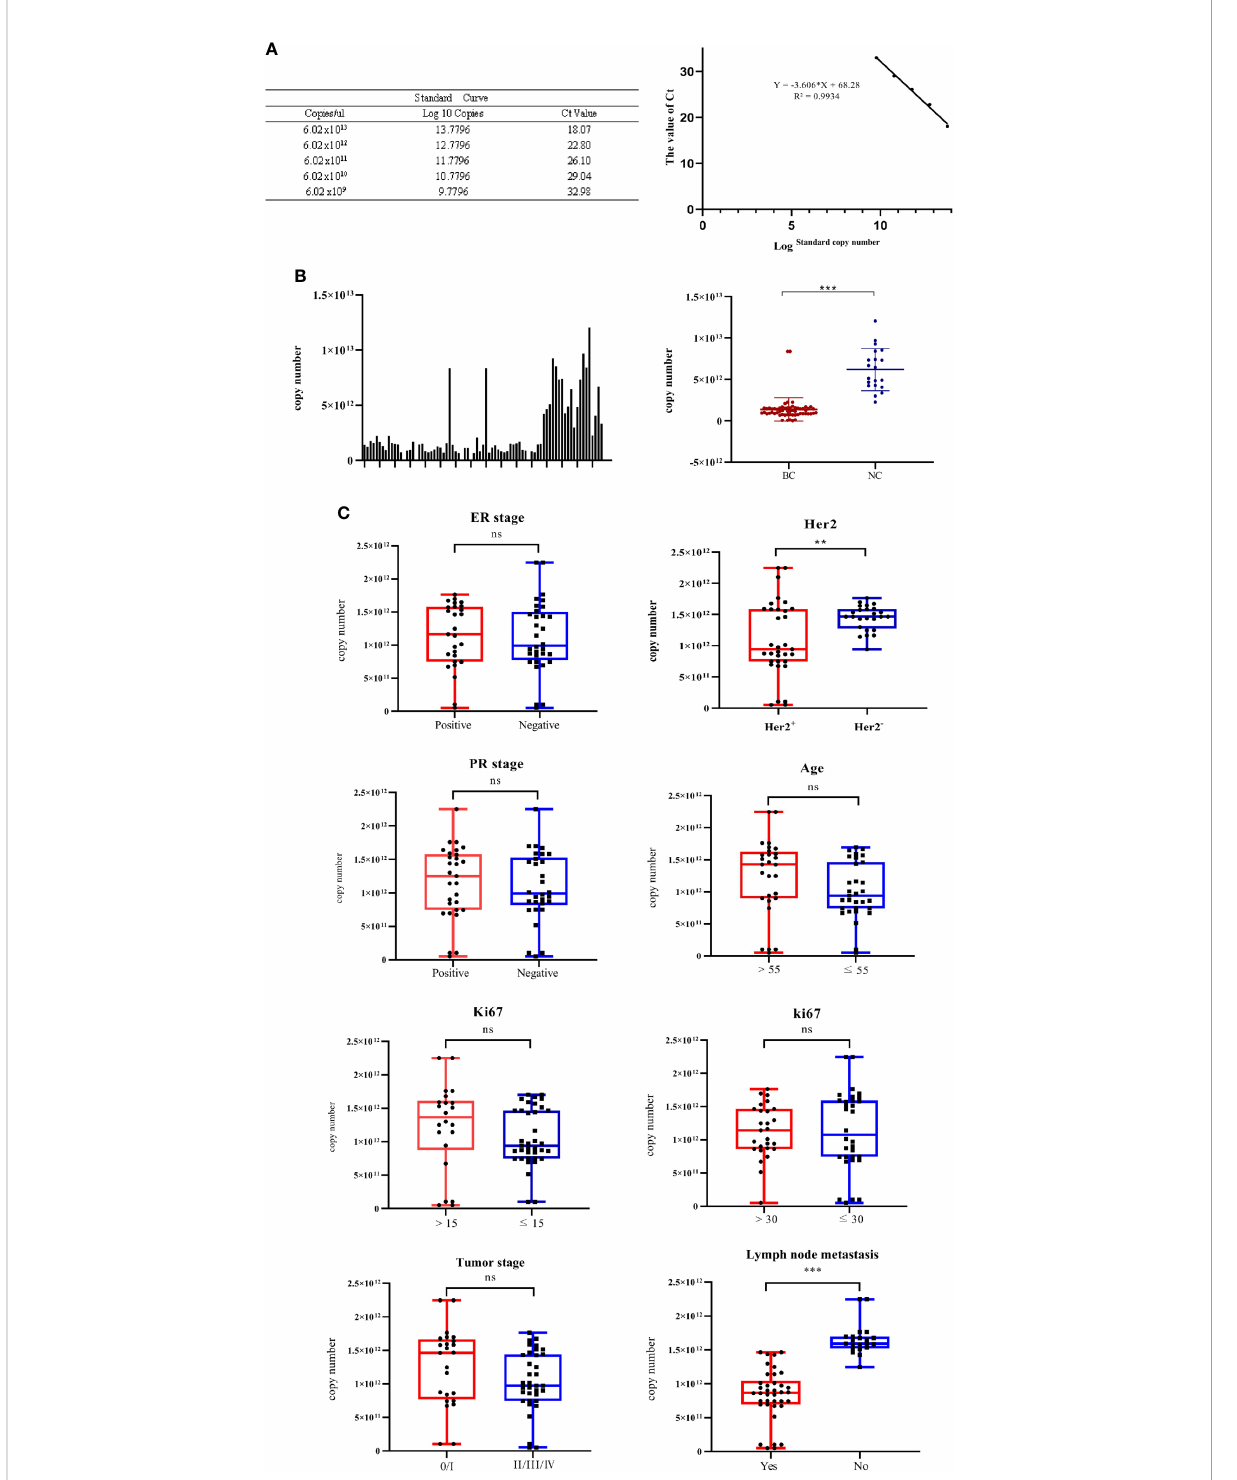
FIGURE 5 The correlations of the levels of exosomal miR-940 with a spectrum of pathophysiological parameters in cancer patients were tested. (A) Standard linear regression curve of miR-940. (B) The copy number of miR-940 transcripts per nanogram of exosomal RNA in each column sample, and the copy number of miR-940 in serum exosomes of breast cancer patients was signi fi cantly lower than that of normal controls. (C) Correlations of the levels of exosomal miR-940 with a spectrum of pathophysiological parameters in cancer patients. (*p<0.05, **p<0.01, ***p<0.001, no signi fi cance, ns